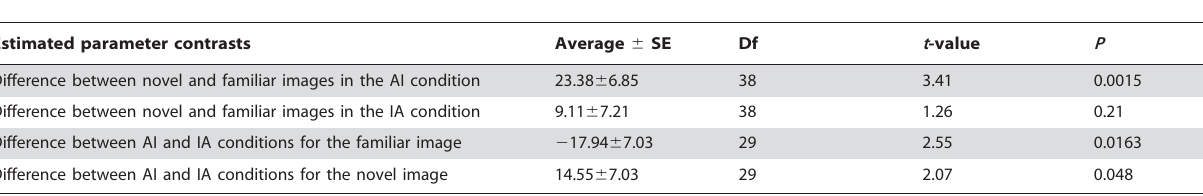
Table 2. GLMM parameter estimate coefficients in Experiment